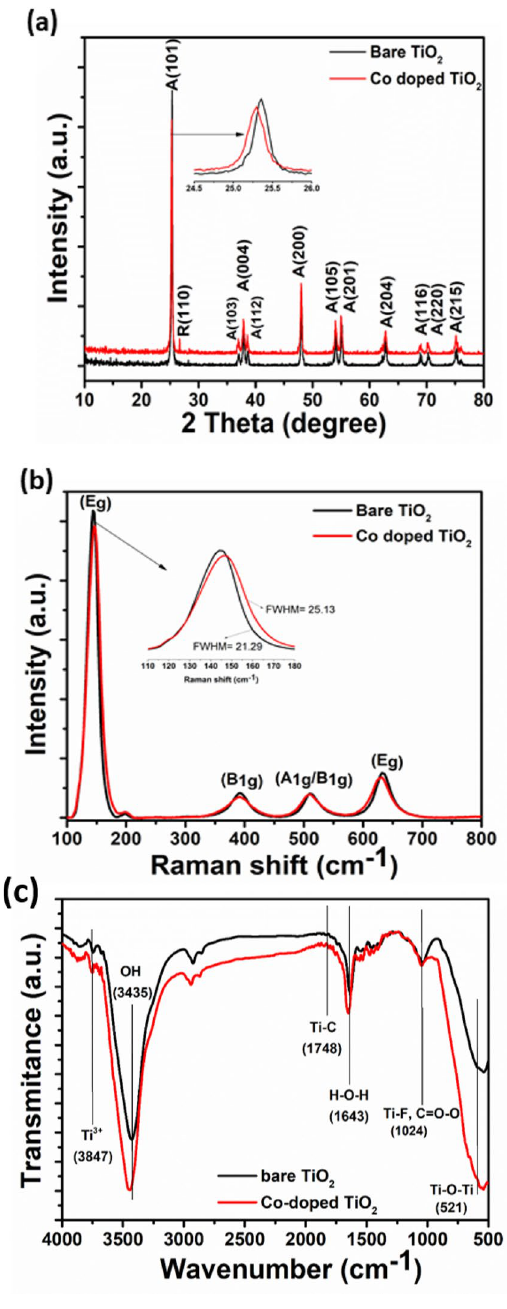
Figure 1. The ( a ) XRD patterns, ( b ) Raman, and ( c ) FT-IR spectra of the bare and Co-doped TiO 2